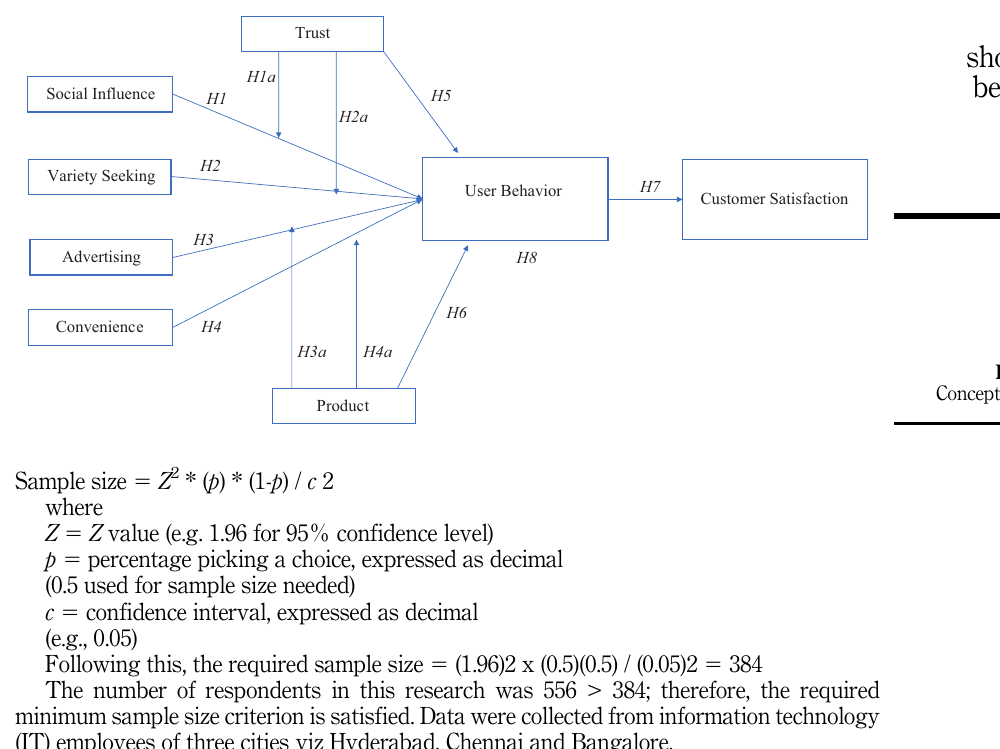
Figure 1. Conceptual